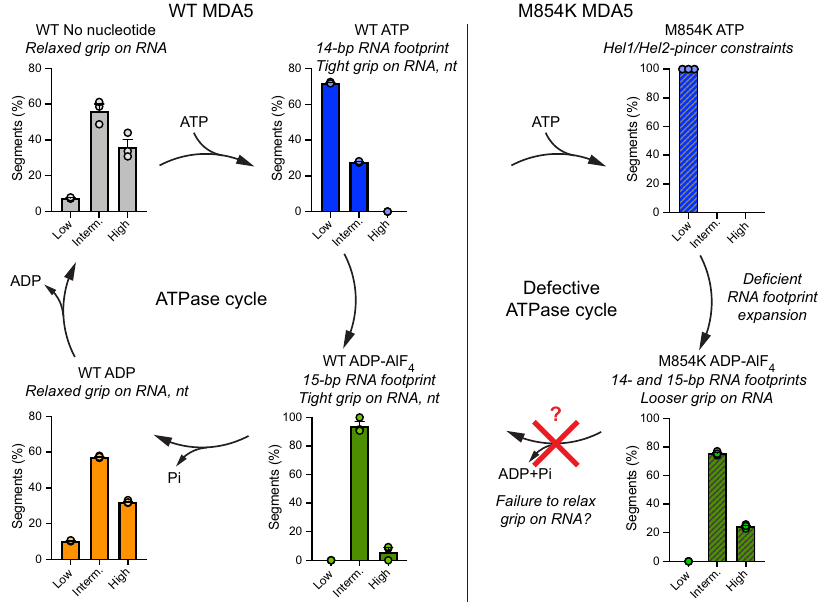
Fig. 6 Helical twist of MDA5 fi laments in the ATPase cycle and proposed effect of M854K on the twist. Histograms showing the distributions of 3D cryoEM reconstructions as a function of helical twist for WT and M854K MDA5-dsRNA fi laments with ATP, ADP-AlF 4 , ADP, or no nucleotide bound. The distributions shown are from 3D classi fi cations performed with ten classes per dataset. Error bars represent SEM between 3D classi fi cation calculations, centered on the mean ( n = 3 independent calculations). The histograms for nucleotide-free, ATP-bound, and ADP-AlF 4 -bound WT MDA5-RNA fi laments are from data reported previously 14 . Low, twist = 71 ˚ – 81 ˚ ; Interm., twist = 81 ˚ – 91 ˚ ; High, twist = 91 ˚ – 96 ˚ . “ nt ” , ANP nucleotide. See also Supplementary Fig. 8. Source data are provided as a Source Data fi